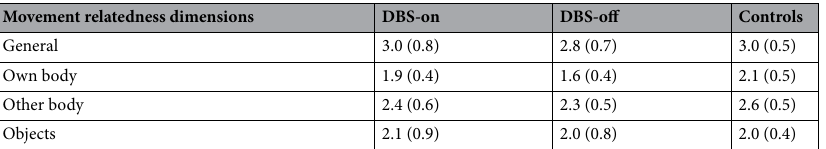
Table 4. Mean ratings of word motor relatedness. Values show the means and standard deviations (in brackets) of word motor relatedness per group and DBS condition.